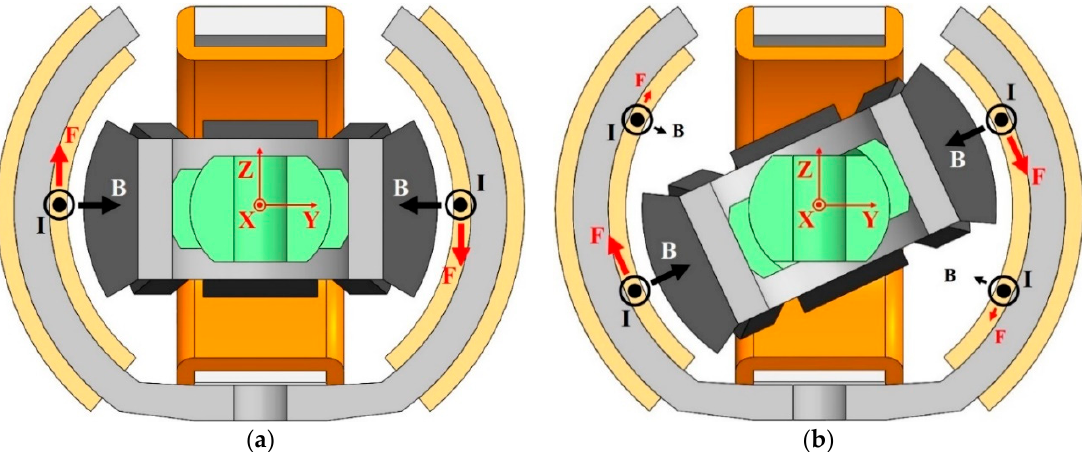
Figure 4. Y-Z cross-section of original 3-DOF spherical motor when the rotor is rotating around the X -axis at ( a ) 0° and ( b ) 25°, respectively.